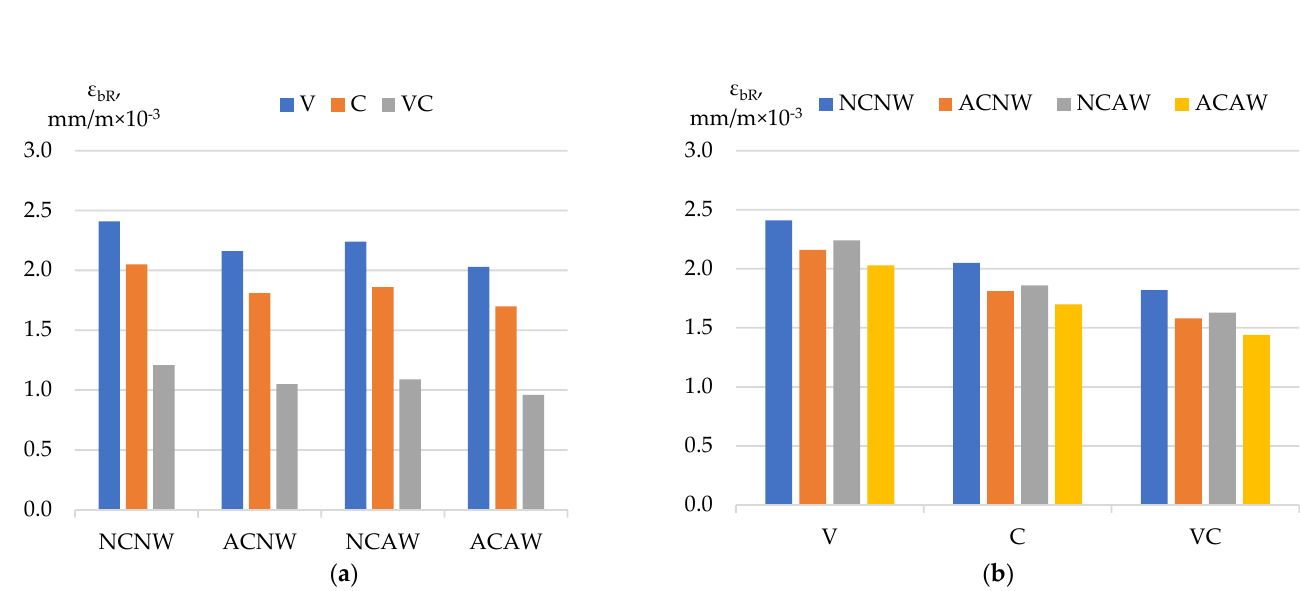
Figure 9. Dependence of deformations during axial compression of concrete: ( a ) on the type of activation, ( b ) on the type of technology for its manufacture.